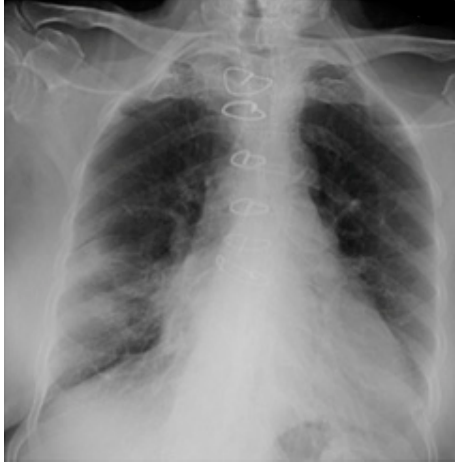
Figure 2. Unilateral–unilobar—hazy, right lower lobe infiltrate.